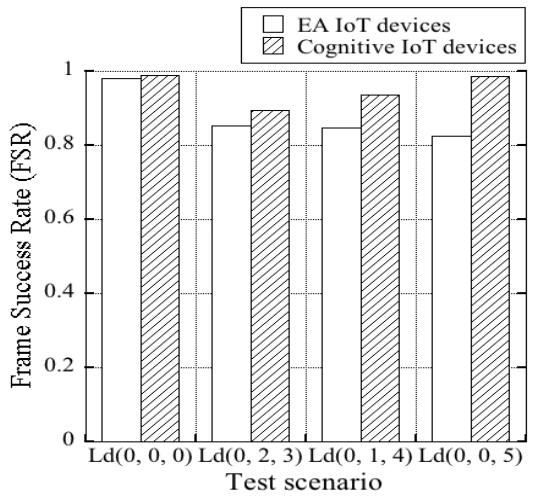
Figure 9. Frame Successful Ratio (FSR) results.